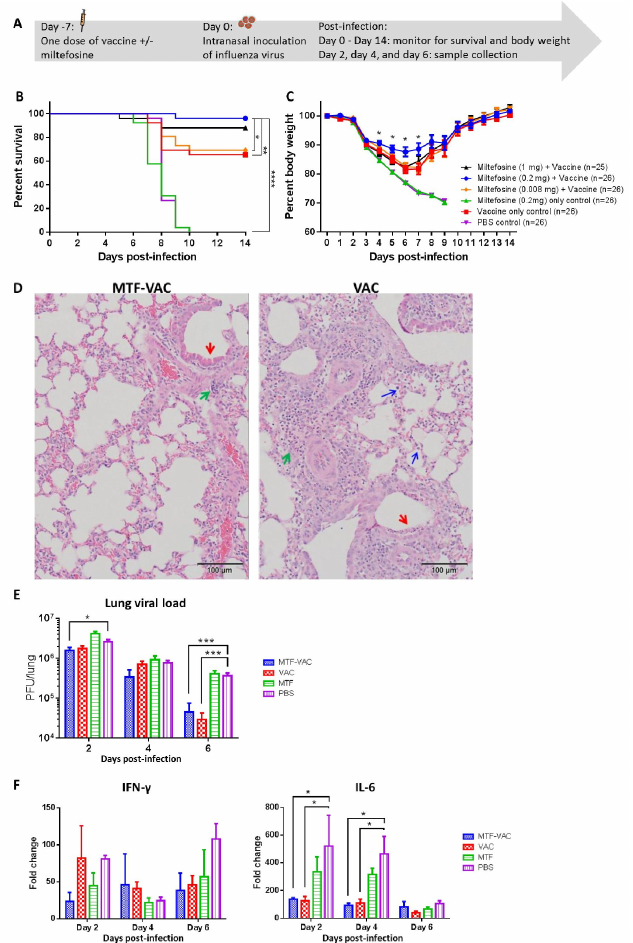
Figure 1. The effect of a single dose of vaccine on mice administrated 7 days before influenza virus challenge. Mice were vaccinated intraperitoneally with a split-virion influenza vaccine with or without miltefosine (MTF) in 200 µL. On the day of the virus challenge, 10LD 50 of mouse-adapted A(H1N1)pdm09 virus was inoculated through the intranasal route in 40 µL. ( A ) Schedule of influenza vaccination, virus challenge, and sample collection. ( B ) Survival curve of mice. ( C ) Body weight curve of mice. ( D ) Representative hematoxylin and eosin (H&E) staining of lungs from MTF-adjuvanted vaccine (MTF-VAC) and VAC mice on 6 dpi; red arrows indicate epithelial cell layer damage in bronchioli; green arrows indicate lymphoid cell infiltration; blue arrows indicate monocytes and neutrophils entering alveolar space. ( E ) Pulmonary viral load post-infection ( n = 6 per group). ( F ) Fold change of cytokine mRNA levels in lung tissue post-infection ( n = 3 per group). For ( D – F ), MTF-VAC, miltefosine (0.2 mg) + vaccine group; VAC, vaccine only group; MTF, miltefosine (0.2 mg) only group; PBS, PBS only group. Data collected from 25–26 mice (4 independent experiments) for survival experiments. Log–rank (Mantel–Cox) test was used for survival comparison; multiple t -tests were used for body weight comparisons. Pulmonary viral load was determined by plaque assay and the statistical comparisons were conducted through multiple t -tests. Cytokine levels were assessed by RT-qPCR. Relative expression levels of target genes were normalized by β -actin expression level and fold change was calculated by comparing to naïve mice. Statistical comparisons were conducted by two-way ANOVA followed by a Tukey’s multiple comparison test. * for p < 0.05; *** for p < 0.001. Error bars represent standard error of the mean (SEM).